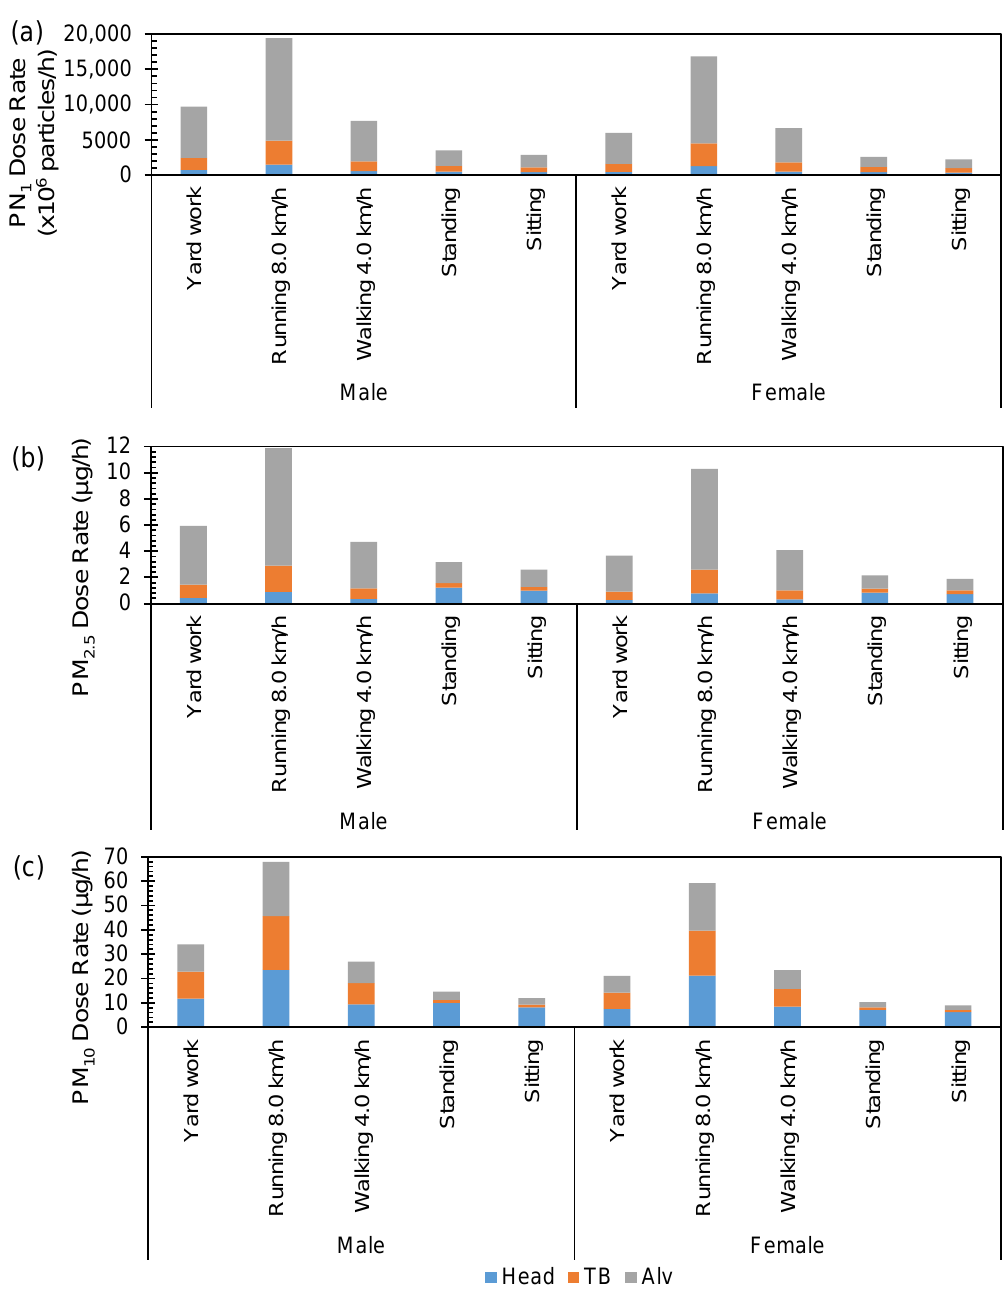
Figure 5. Regional inhaled deposited dose rates calculated for different activities during indoor background conditions for: ( a ) sub-micron particle number concentrations (PN 1 ) and ( b , c ) particle mass concentrations (PM 2.5 and PM 10 ). The color legend is: blue—head airways (head), red—tracheobronchial (TB), and gray—alveolar (Alv). Exposure is based on mean concentrations. Note that yardwork is assumed to be equivalent to housework and running is equivalent to indoor exercising.